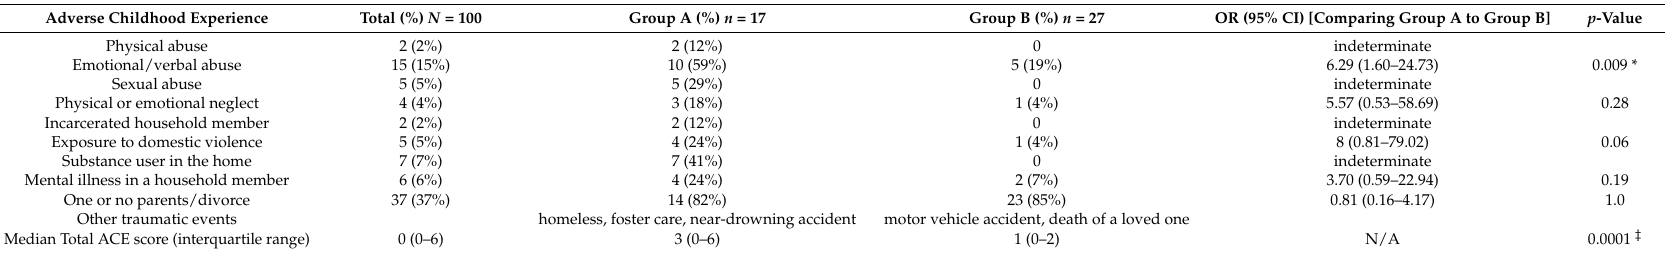
Table 3. Comparison of adverse childhood experiences between patients with ≥ 4 medically unexplained symptoms (Group A) and 0–3 medically unexplained symptoms (Group